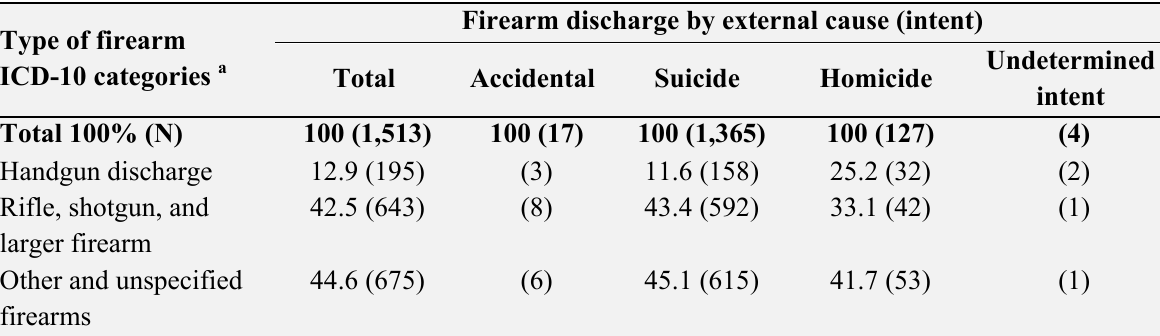
Table 6. Deaths due to firearm discharge by type of firearm and intent 1996–2009, %